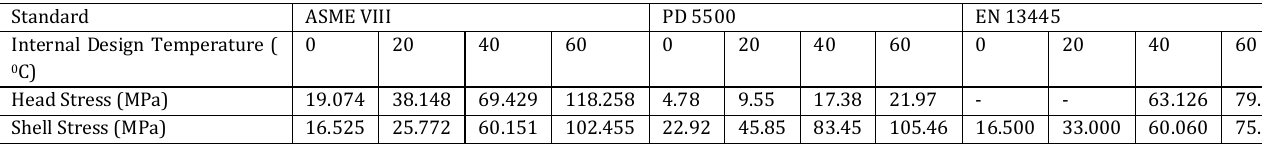
Table 4: Stress for each element